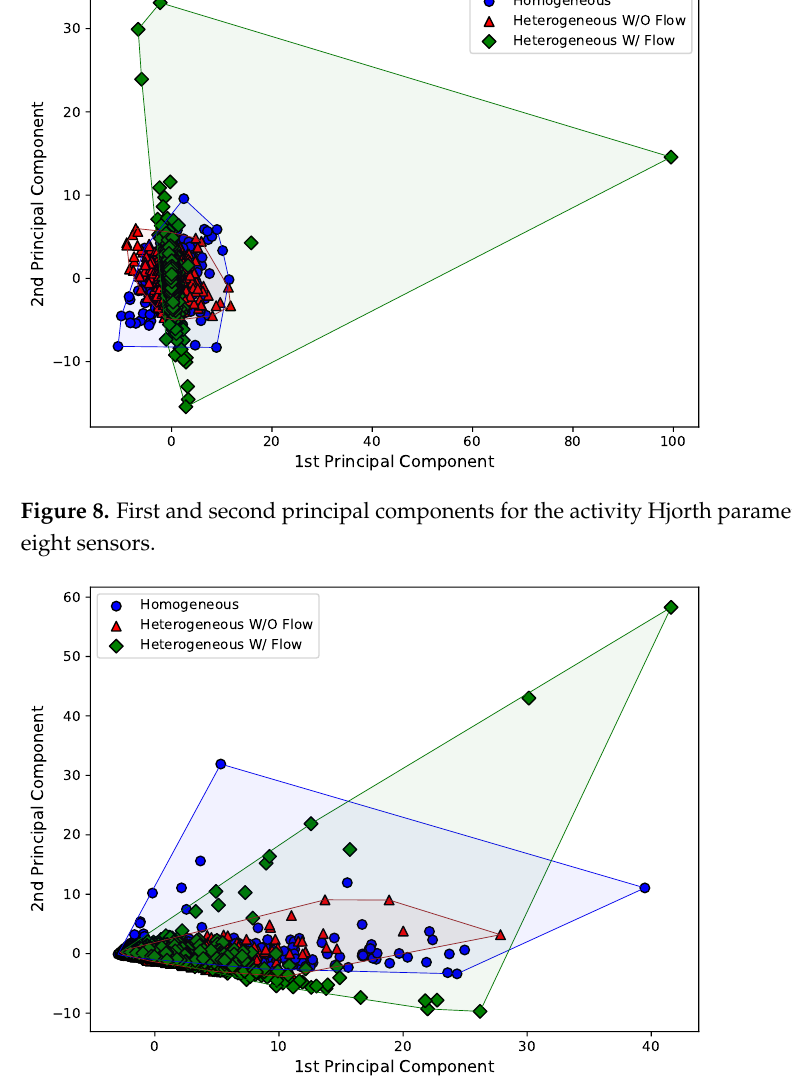
Figure 9. First and second principal components for the mobility Hjorth parameter considering all the eight